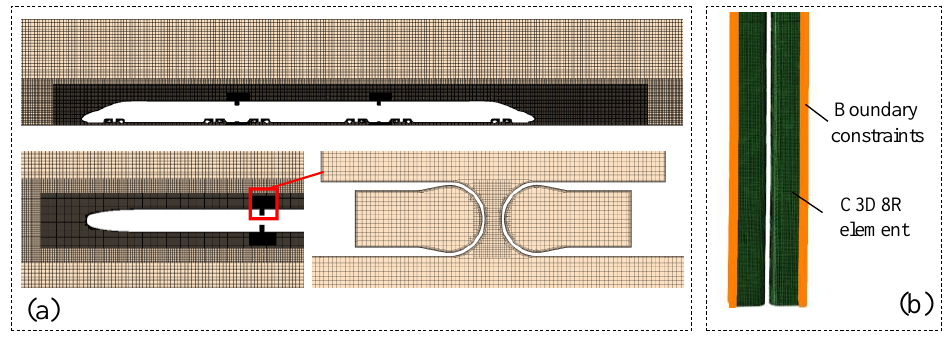
Figure 4. Mesh discretization: ( a ) mesh of the fluid domain, ( b ) mesh of external windshield. This study carries out a mechanical co-simulation using STAR-CCM+ and Abaqus.